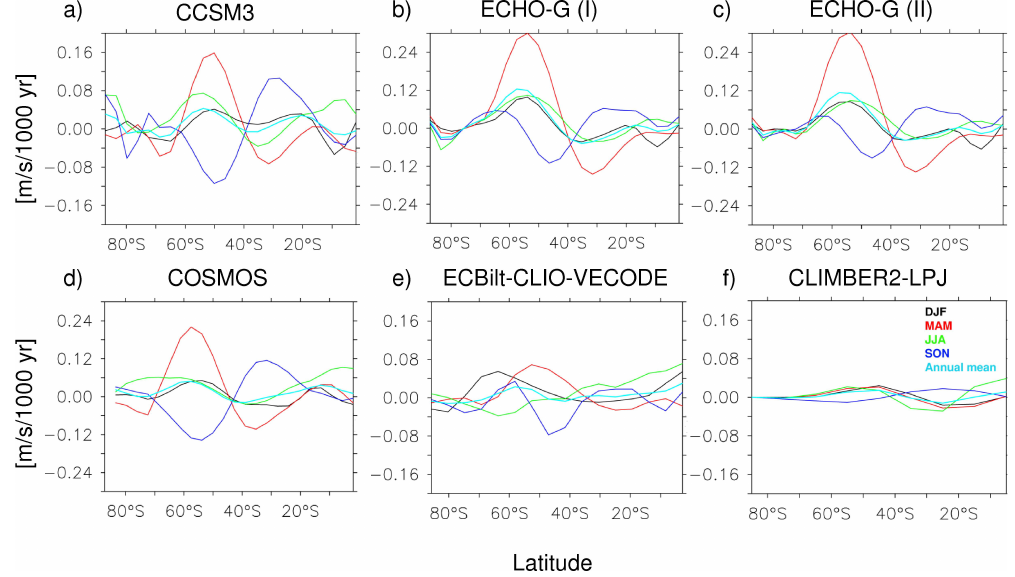
Fig. 5. Zonally averaged seasonal and annual mean trends in the low-level zonal wind in (a) CCSM3, (b) ECHO-G (I), (c) ECHO-G (II), (d) COSMOS, (e) ECBilt-CLIO-VECODE, and (d) CLIMBER2-LPJ for the Southern Hemisphere for the period 7kyr BP to 250yr BP. Note the different ordinate